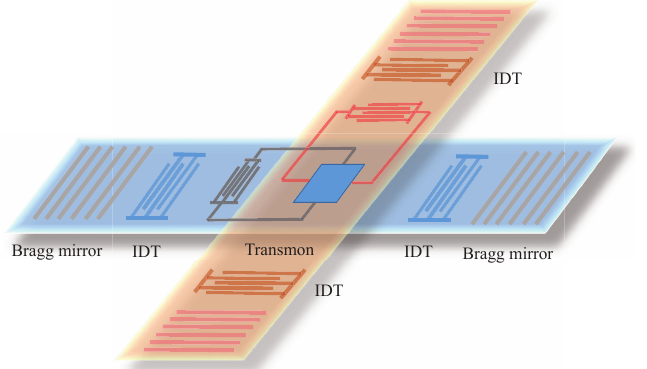
Figure 1. Schematic illustration of the proposed circuit quantum acoustodynamical system consisting of a superconducting transmon qubit coupled to two SAW resonators. Each SAW resonator is defined by a pair of Bragg mirrors and contains two identical interdigitated transducers (IDTs). These IDTs, situated inside the acoustic resonators, are formed by periodic arrays of identical electrodes, which can be used to excite and probe the SAW. A transmon qubit is located in the middle of a SAW resonator and coupled to the SAW mode via an IDT through the piezoelectric substrates. In addition, the transmon qubit lies in the intersection region of these two perpendicular SAW resonators so that the transmon qubit could be coupled to both of the acoustic